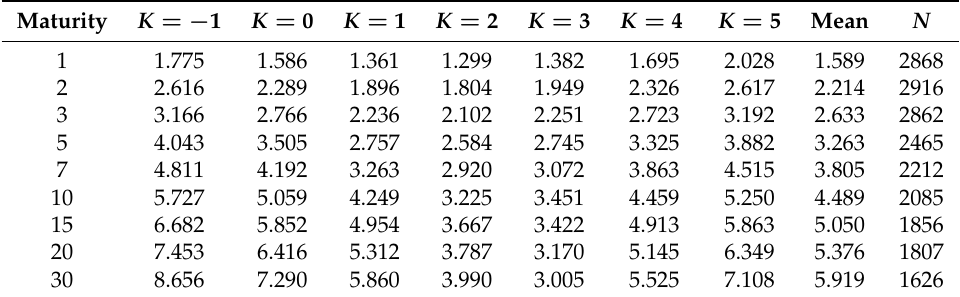
Table 3. Summary statistics for inflation option implied